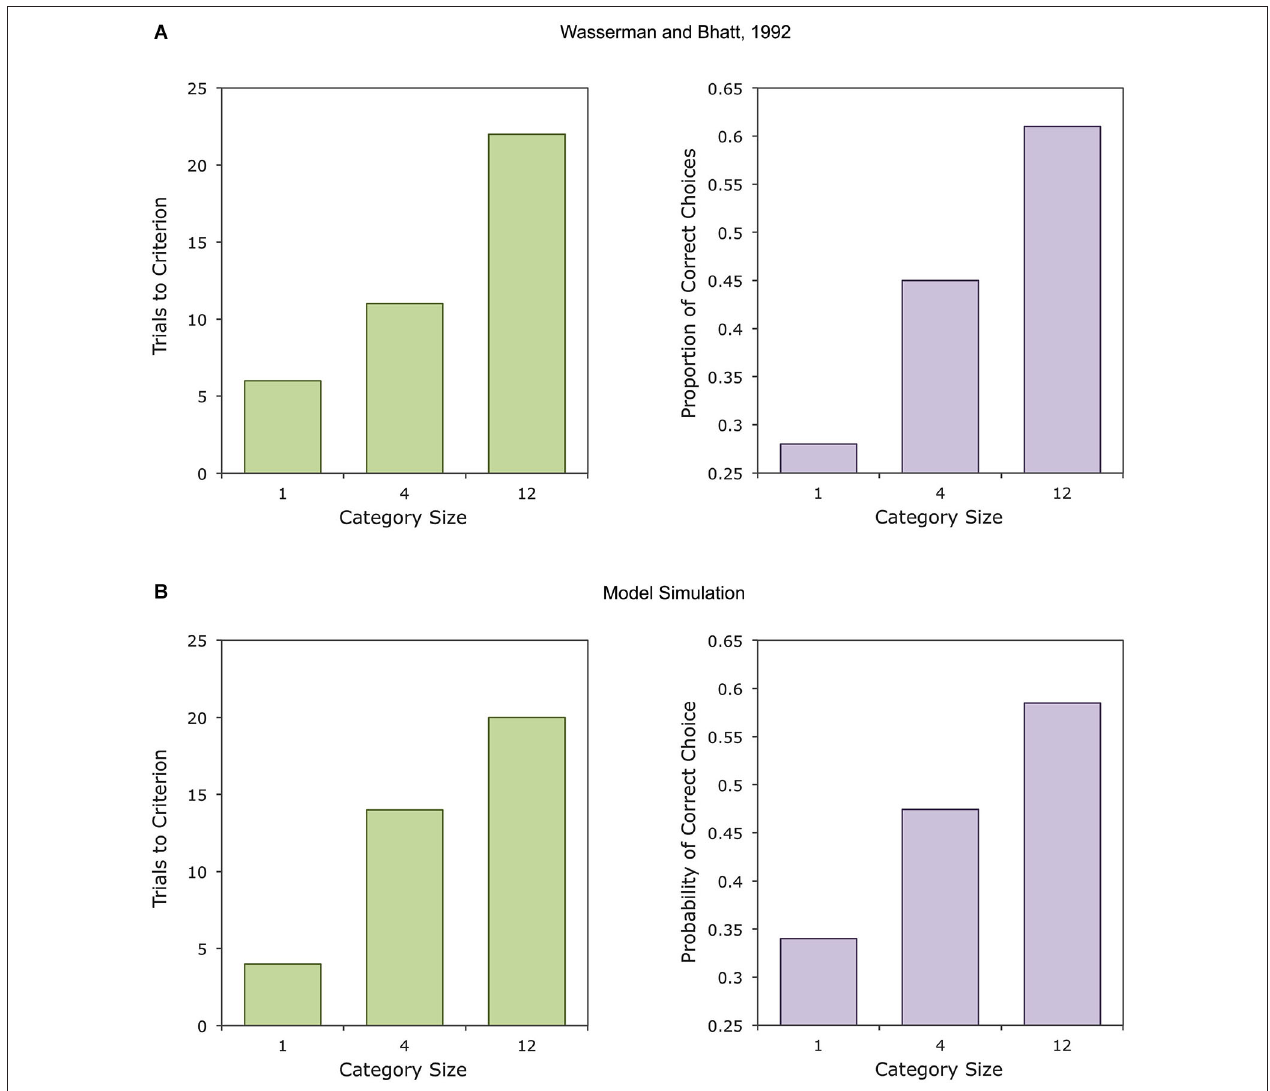
number of trials to reach a criterion of 0.7 proportion correct (left) and increases generalization to novel objects from the trained categories